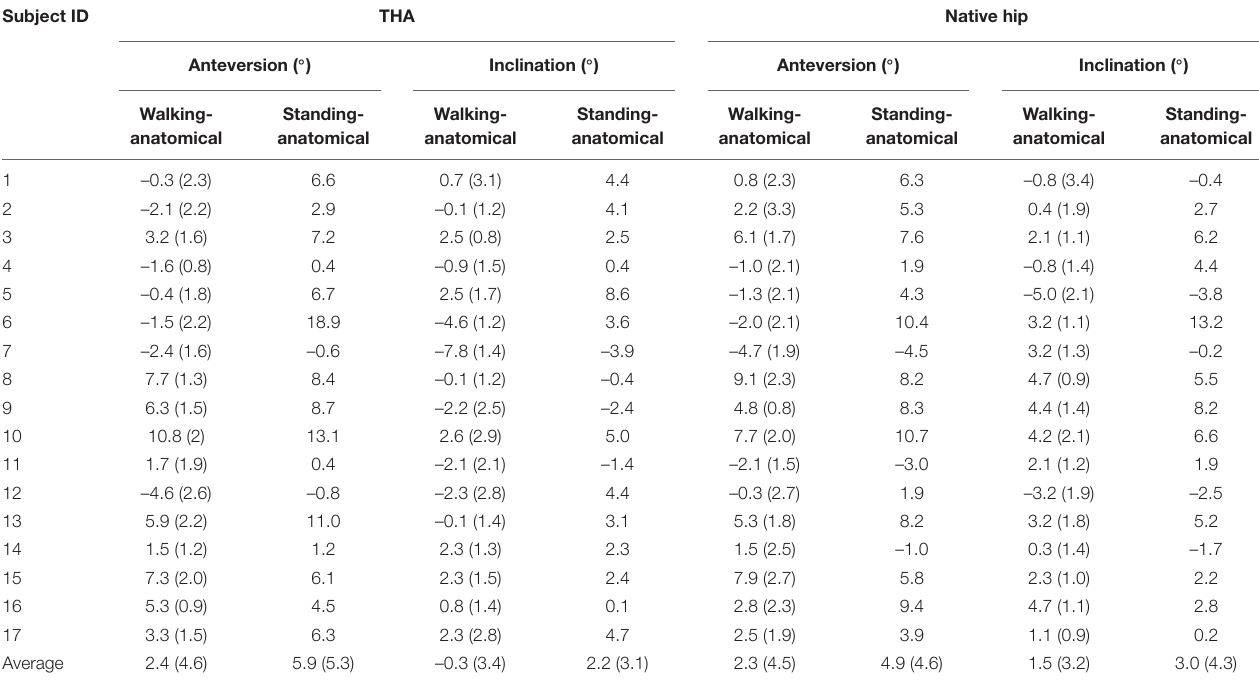
TABLE 2 | Differences between functional and anatomical acetabular anteversion and inclination in both THA and native hips for unilateral THA